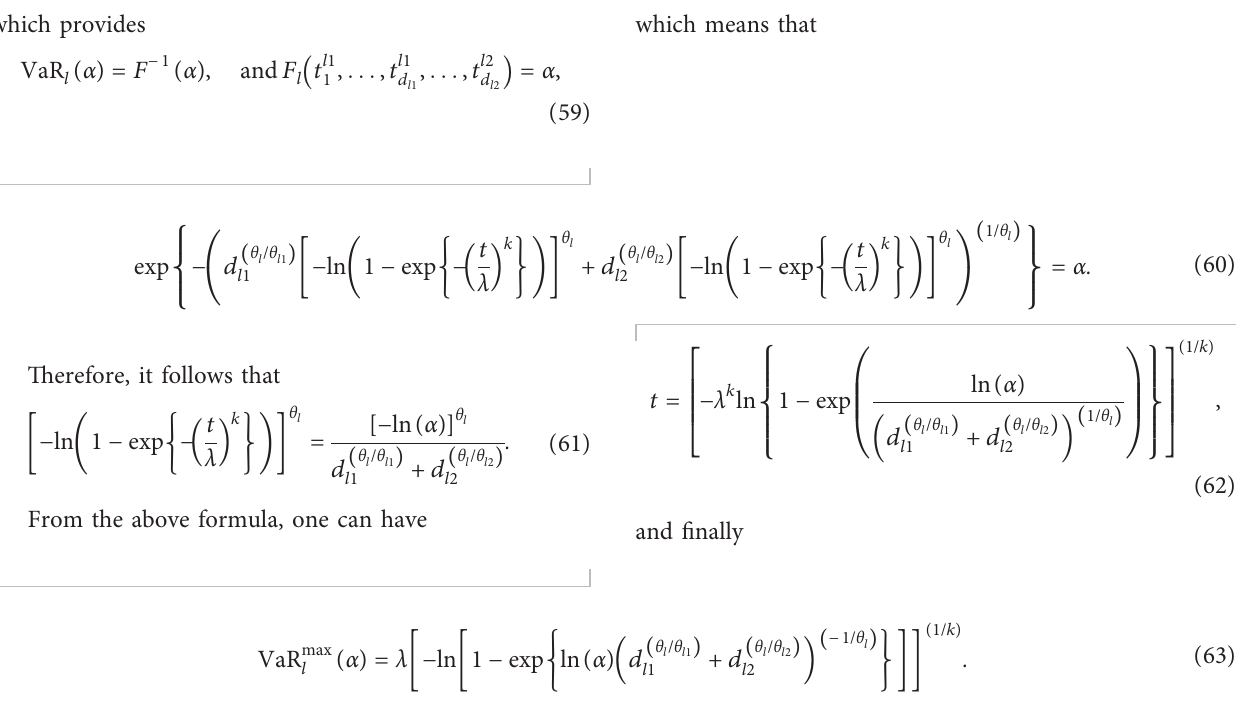
� 20, θ � 8 for all l ∈ 1 , ... ,s { } and i ∈ 1 , 2 { } in a li li